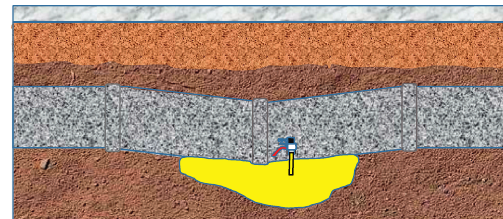
Figure 1: Polymer grouting